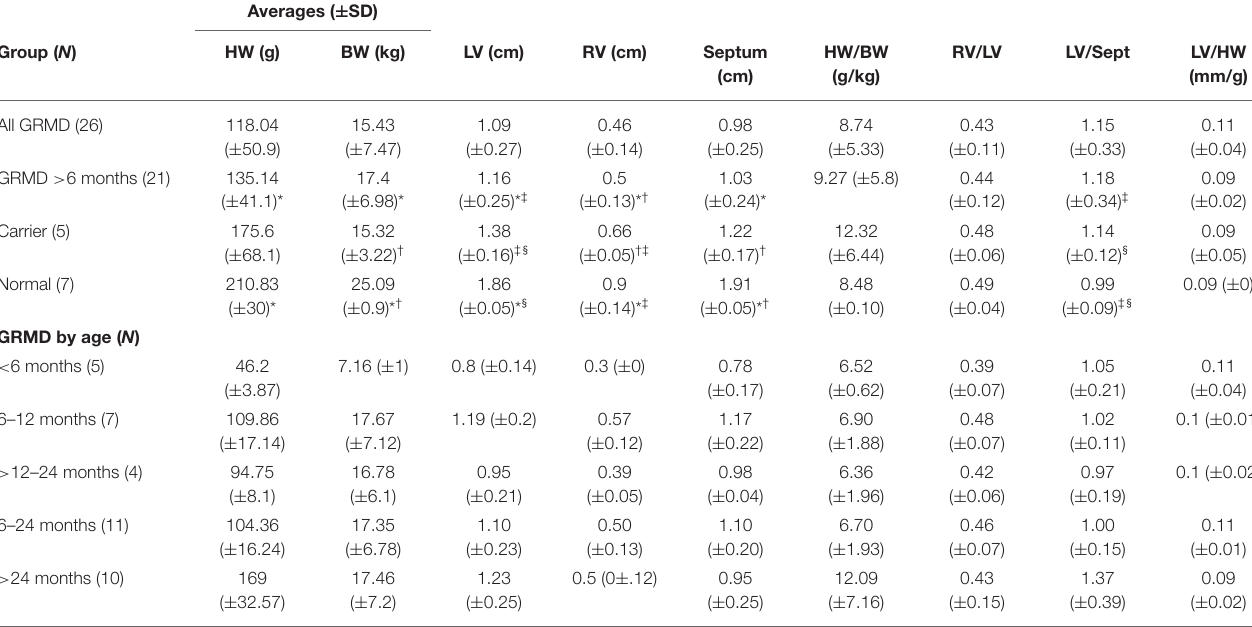
TABLE 1 | Averages of gross heart measurements for Golden Retriever muscular dystrophy (GRMD), carrier, and normal dogs. Averages ( ±